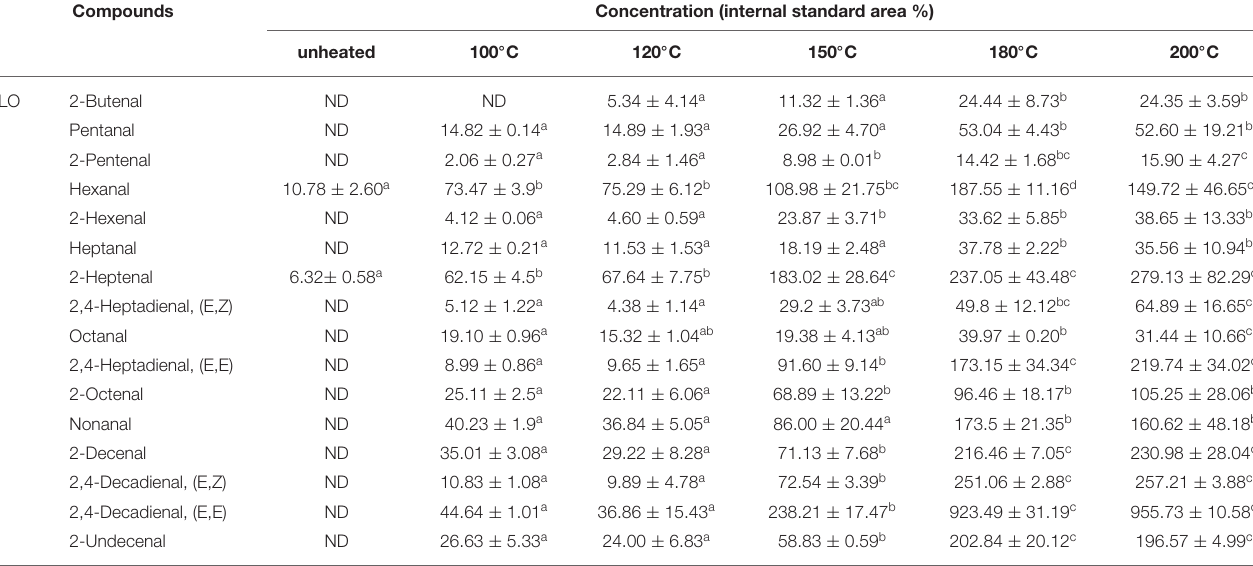
TABLE 2 | Changes in the volatile oxidation products of LO at different heating